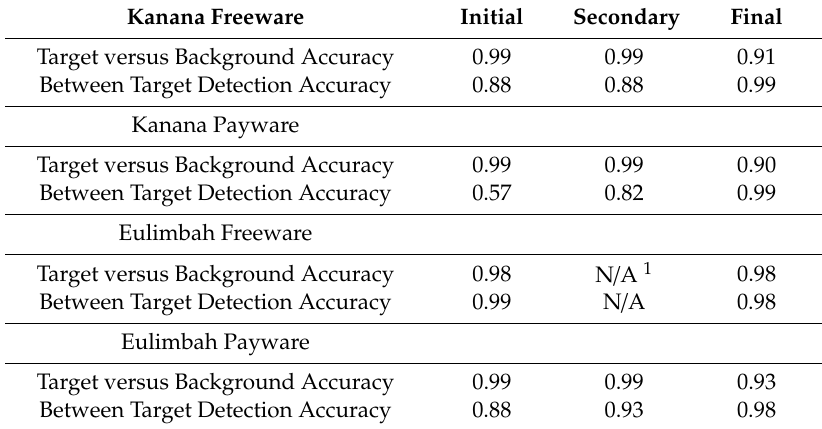
Table 3. Results for the freeware and payware used in the development of semi-automated counting methods for the Kanana and Eulimbah colonies, showing the initial, secondary (after correcting for probabilities) and final model accuracies (after correcting for area).